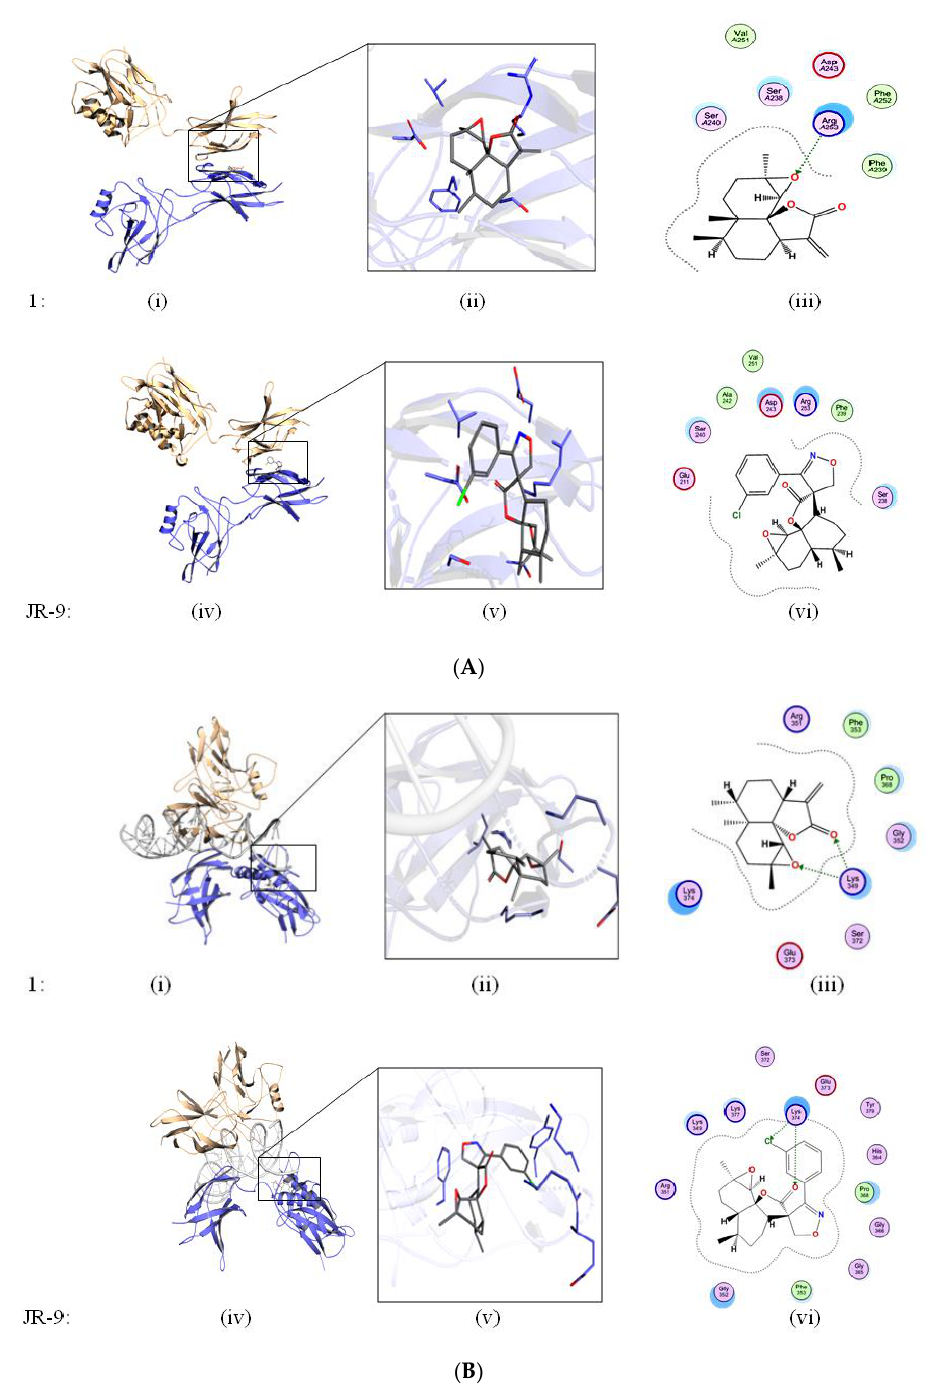
Figure 5. ( A ) Ligands docked at Dimeric site. In silico studies to determine the binding interaction of 1 and JR-9 with ligands docked at dimeric interface site. The molecular operating environment (MOE2019) was used to assess the behavior of 1 and JR-9 in the binding site of NF-κB. Green lines show the iconic interaction of the molecule with that of different amino acids. The interacting residues within the 4.5 Å of the ligand are shown in 2D diagram. ( B ) Ligands docked at DNA-binding site. In silico studies to determine the binding interaction of 1 and JR-9 with ligands docked at DNA binding site. The molecular operating environment (MOE2019) was used to assess the be-